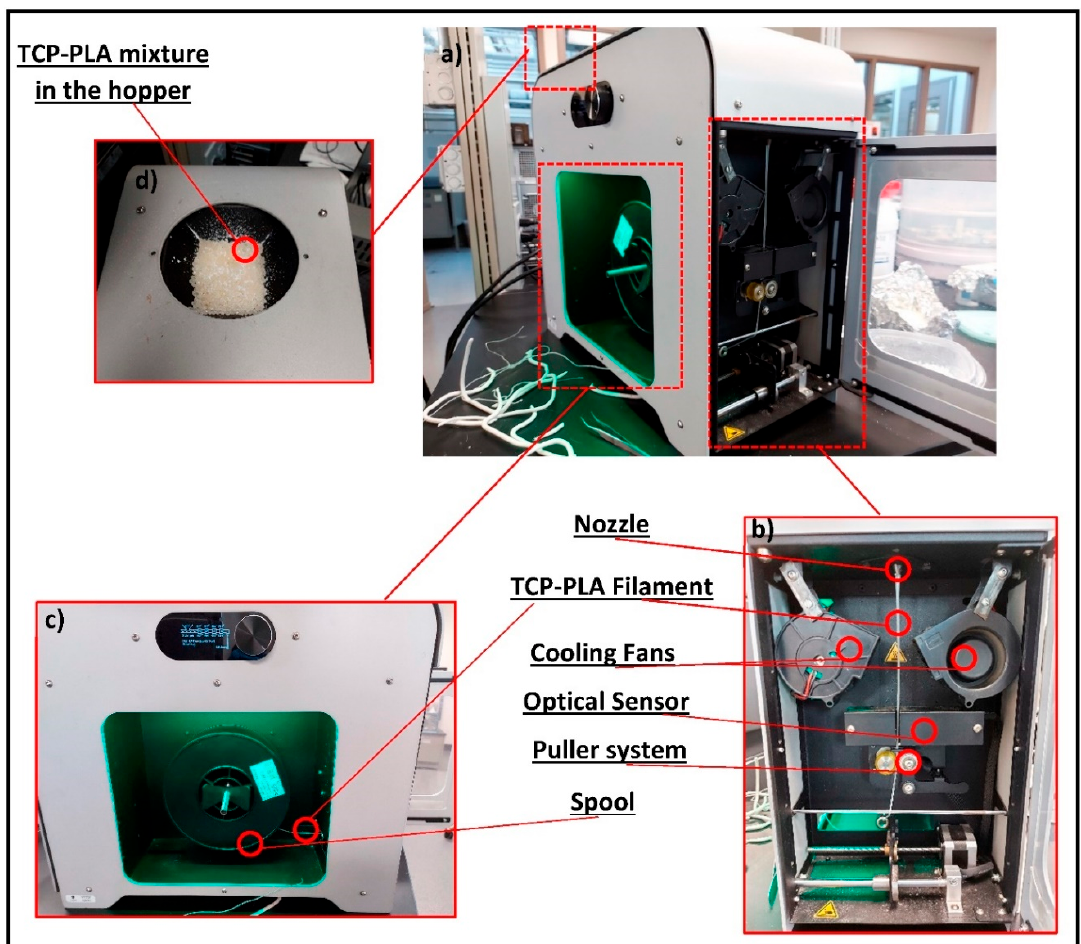
Figure 1. Fabrication process of 3D printable TCP–PLA composite filament. ( a ) 3Devo filament maker extruder. ( b ) Front view of the extruder showing the filament extrusion out of the nozzle to the puller system. ( c ) Side view of the extruder showing the spooling process of the filament. ( d ) Top view showing the TCP powder with the PLA pellets in the hopper.